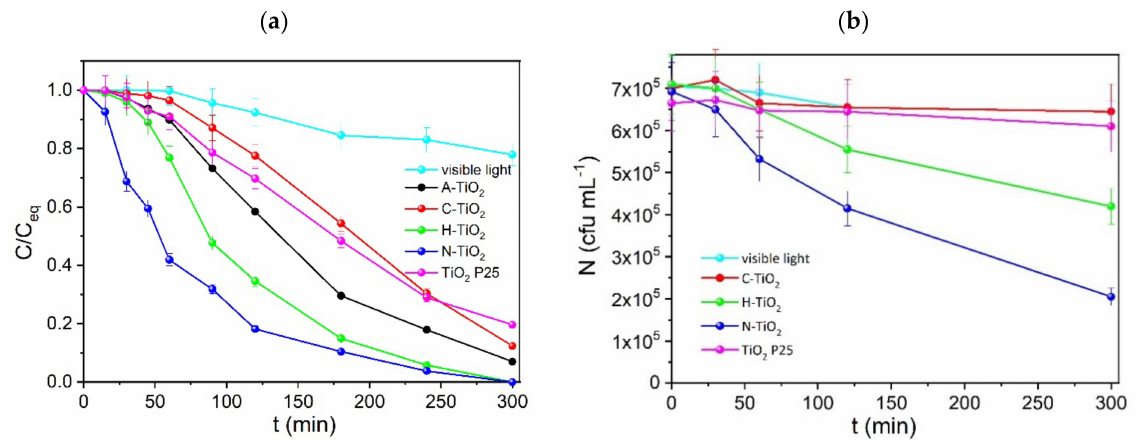
Figure 7. Photocatalytic decolorization of MG ( a ) and inactivation of G. stearothermophilus endospores ( b ) under visible light illumination. In all cases 0.5 g L − 1 of the corresponding photocatalyst were